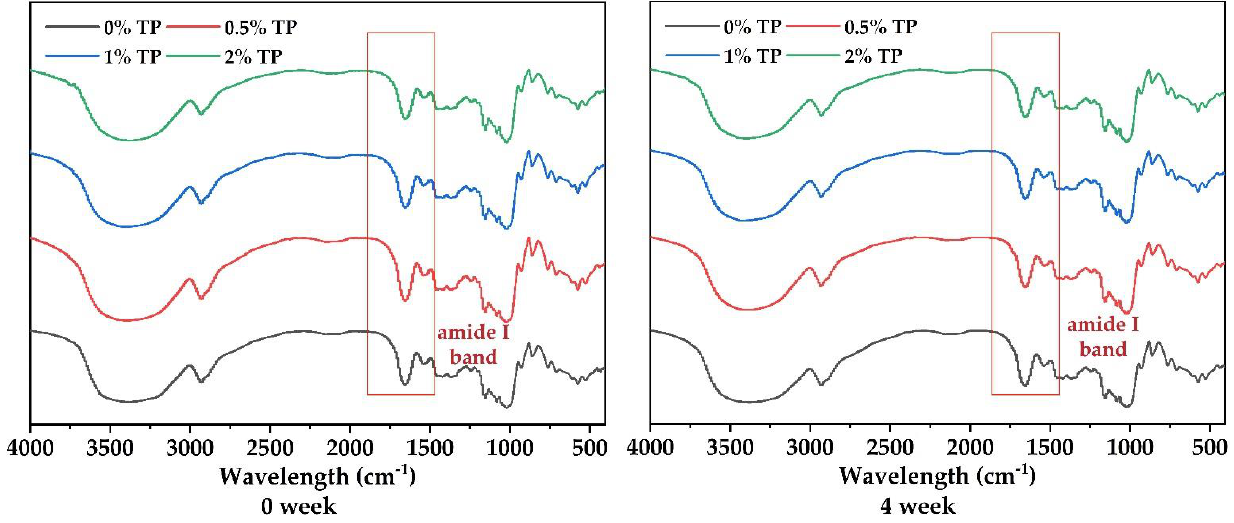
Figure 5. Infrared spectra of NFFD at both 0 and 4 weeks, stored at − 20 °C with various TP additions.